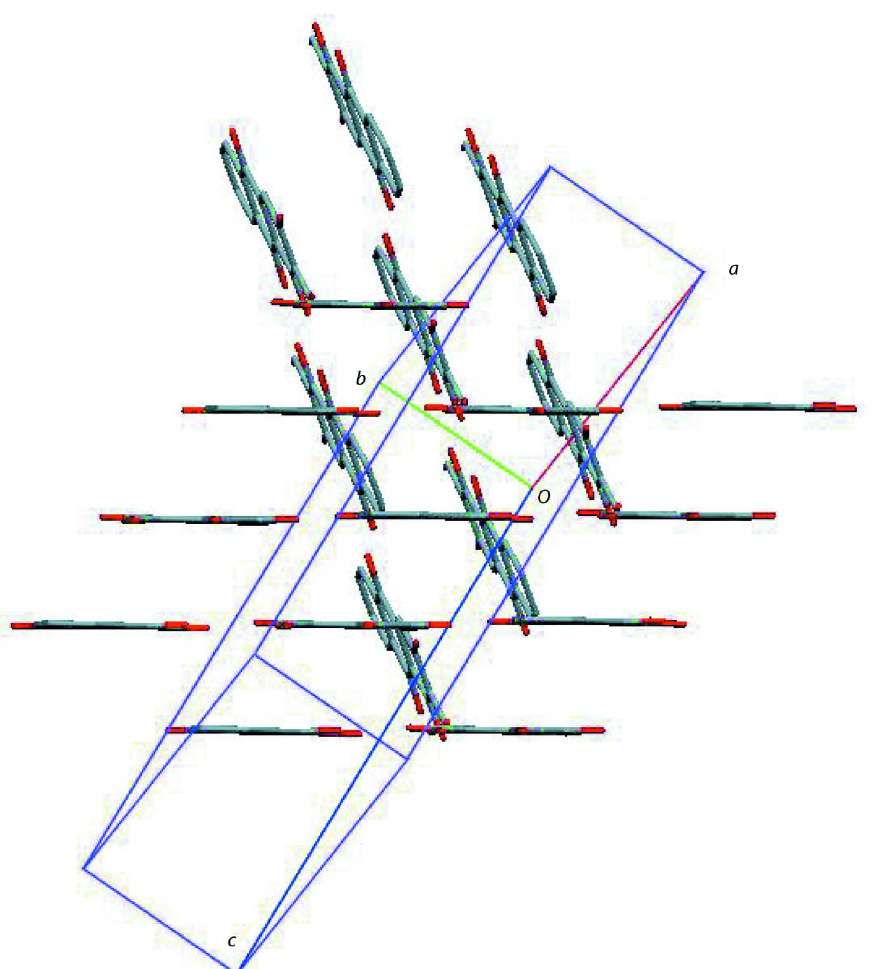
The crystal packing showing the two orientations taken by the stacking of molecular tapes. Note the offset between successive